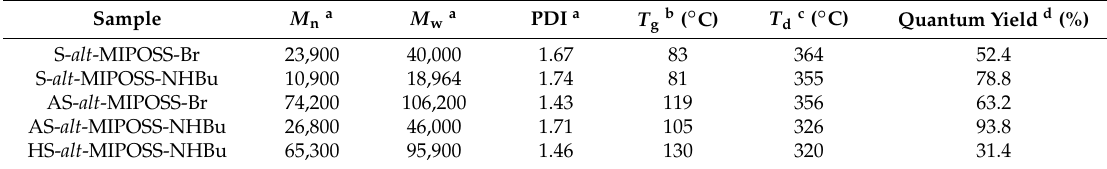
a Measured through GPC analysis; b Measured through DSC; c Measured through TGA; d Measured using an integrated sphere (Ocean Optics).